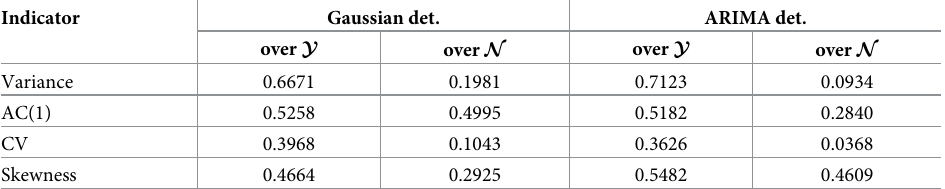
Table 2. AUC scores for different indicators, over Y and N datasets, after Gaussian or ARIMA detrending methods. Indicator Gaussian det. ARIMA